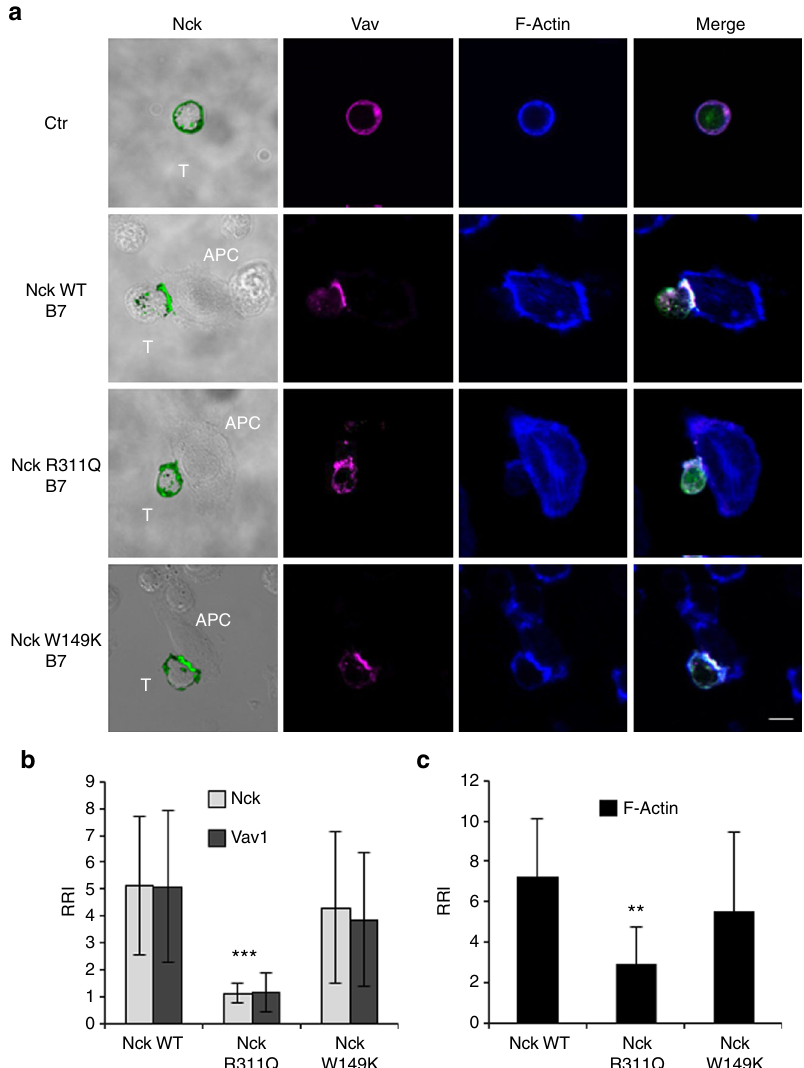
Fig. 8 Nck SH2 domain is required for Vav1 recruitment to CD28 and actin rearrangement and polarisation. a hCD28WT cells were transfected with pm- Cherry Vav1 (magenta) vector together with GFP-Nck WT (green) or a GFP-Nck mutants within the SH2 domain (R311Q) or within the SH3.2 (W149K) domains and then stimulated for 15 min in the absence (Ctr) or presence of Dap3/B7 cells (B7). After fi xing and permeabilisation F-actin was stained with 633-conjugated phalloidin (blue) and analysed by confocal microscopy. The scale bar represents 10 μ m. The frequency of conjugates (total 15) showing signi fi cant (RRI > 2.5) Vav1 and Nck recruitment ( b , c ) or F-actin polarisation ( c ) were calculated and data represent the mean ± SD of three independent experiments. Mean values: Nck WT, Nck = 5.1 ± 2.6, Vav = 5 ± 2.8, F-actin = 7.2 ± 2.9; Nck R311Q, Nck = 1.1 ± 0.3, Vav = 1.1 ± 0.7, F-actin = 2.8 ± 1.8; Nck W149K, Nck = 4.3 ± 2.8, Vav = 3.9 ± 2.4, F-actin = 5.5 ± 3.9. ** p < 0.01, *** p < 0.001 calculated by Student ’ s t- test compared with Nck WT. The results